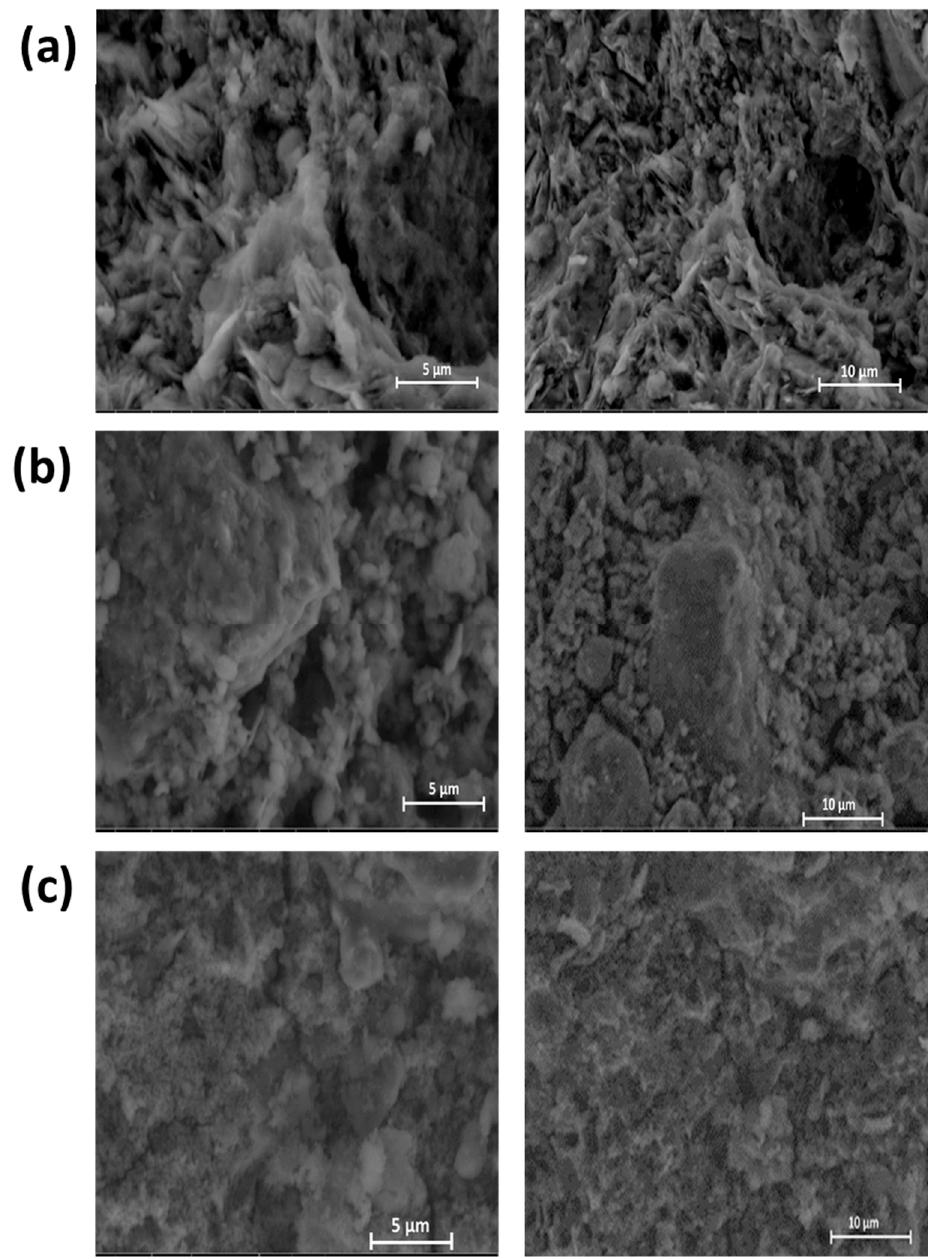
Figure 16. SEM analysis of geopolymeric materials: ( a ) GA 1550 , ( b ) GA 1750 , and ( c ) GA 1950 .